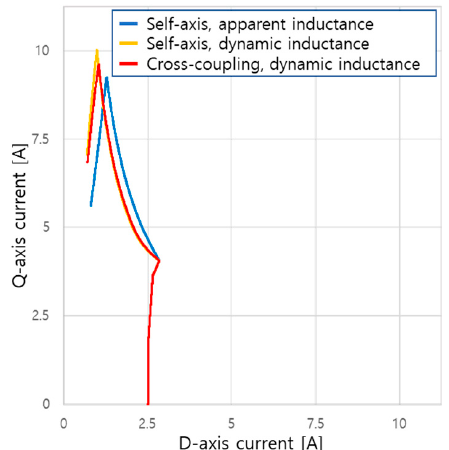
Figure 11. Results of comparing the operating points of the currents in Figures 8, 9, and 10.